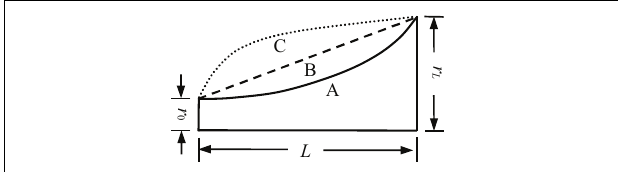
FIGURE 9 | Schematic illustration of diffuse rock rod with variable cross-section. Because the rock rod is axisymmetric, only a half of the rock is presented. Type A: concave rod, the relation between the radius and the traveling distance is r ( x ) = r 0 exp[ x ln( r L / r 0 )/ L ]; Type B: straight rod, the relation between the radius and the traveling distance is r ( x ) = r 0 + ( r L − r 0 ) x / L ; Type C: convex rod, the relation between the radius and the traveling distance is